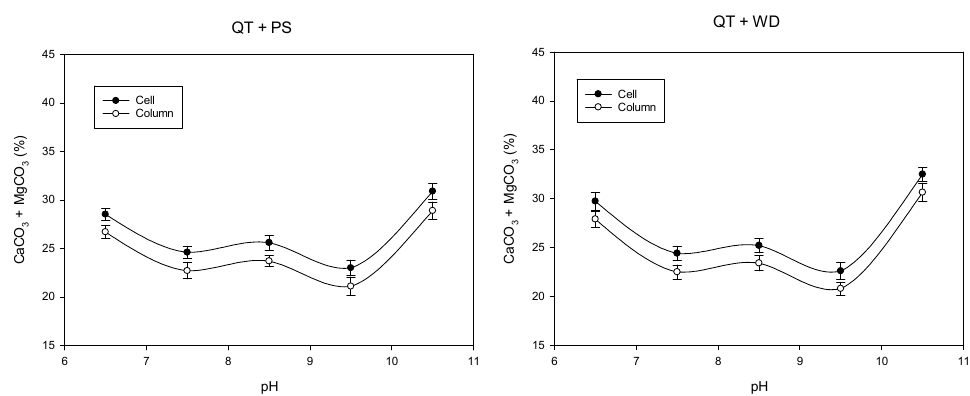
Figure3. CaCO 3 + MgCO 3 (%) onconcentrate for celland columnas pH functionand typeof Figure 3. CaCO 3 + MgCO 3 (%) on concentrate for cell and column as pH function and type of depressant.